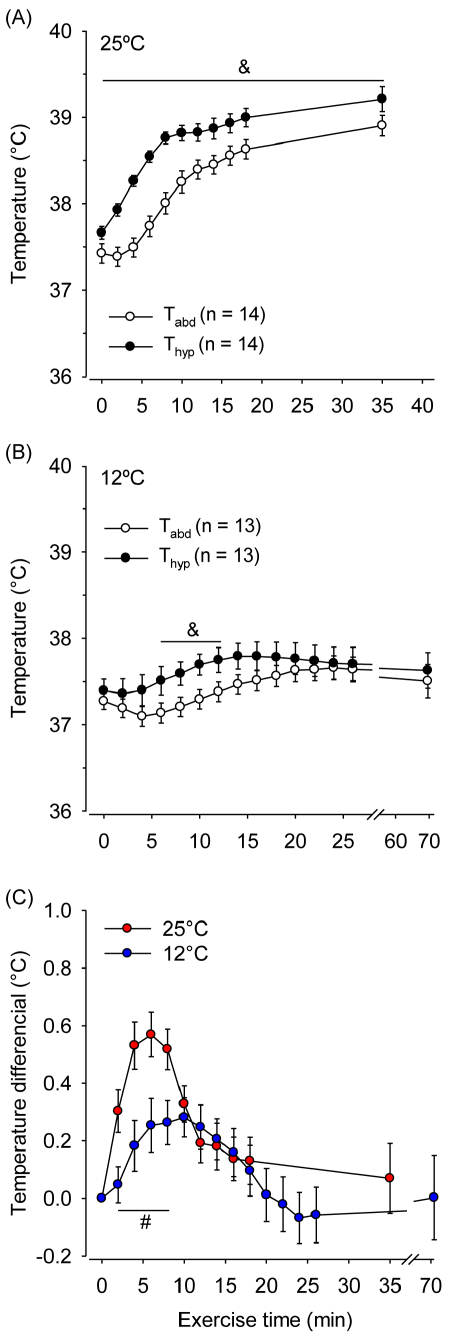
Figure 5. Hypothalamic and abdominal temperatures during constant-speed exercises that were performed until volitional fatigue at ambient temperatures of 25 u C (panel A) and 12 u C (panel B). Panel C shows the hypothalamic-abdominal temperature differentials at both ambient temperatures. & P , 0.05 compared with the abdominal temperature; # P , 0.05 compared with the experimental trial at 25 u C. doi:10.1371/journal.pone.0111501.g005 skin surface of the animals [1]. Furthermore, rats cannot properly engage in behavioral thermoeffectors aimed at heat conservation while they are running on a treadmill (e.g., they cannot assume a ball-like position).